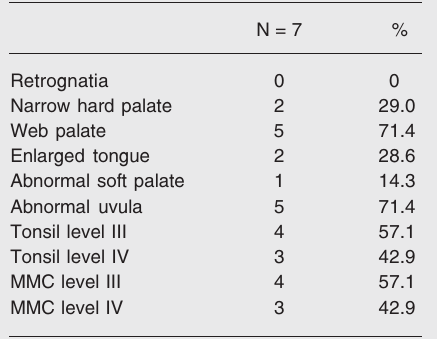
Table 1. Physical examination of the 7 obese patients with obstructive sleep apnea hypopnea syndrome